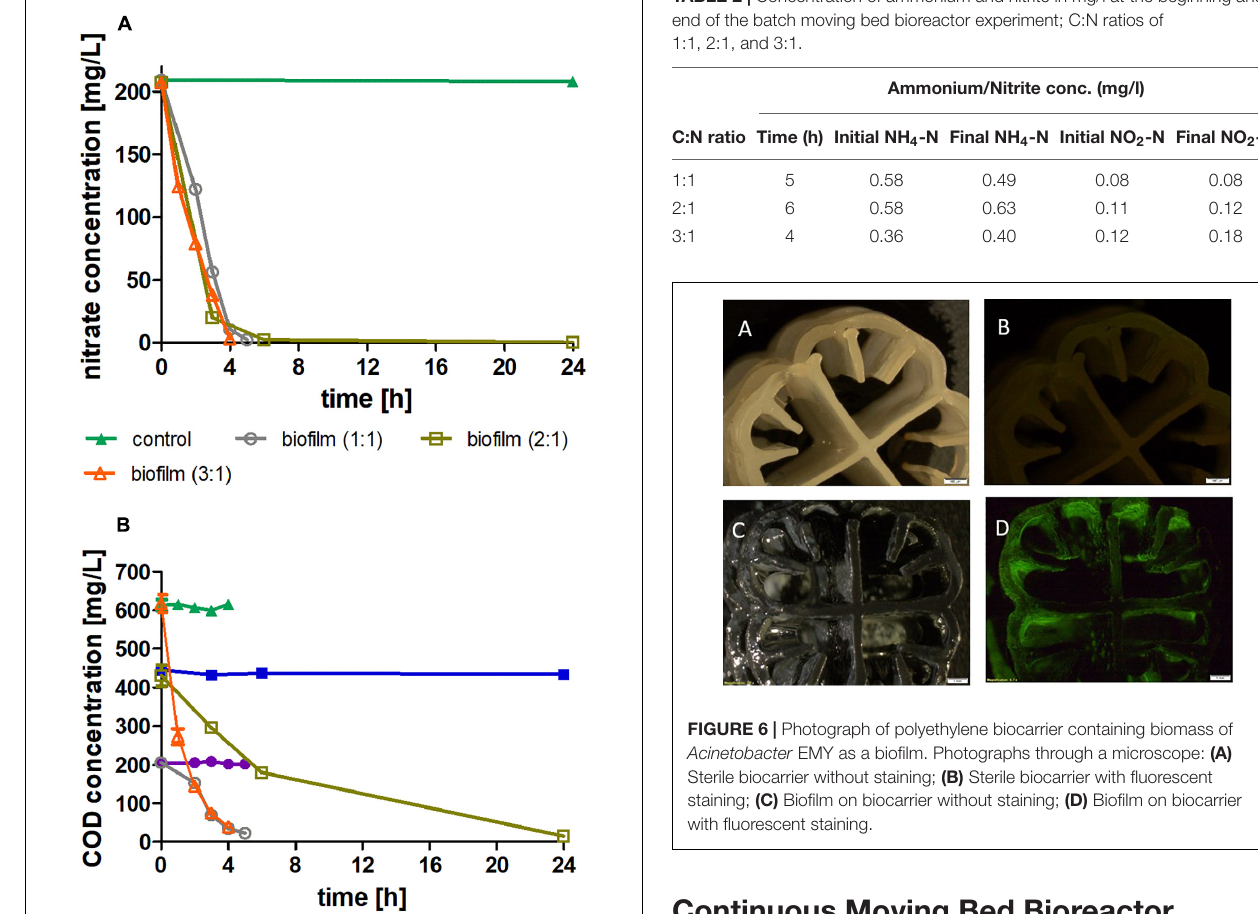
TABLE 2 | Concentration of ammonium and nitrite in mg/l at the beginning and end of the batch moving bed bioreactor experiment; C:N ratios of 1:1, 2:1, and 3:1.